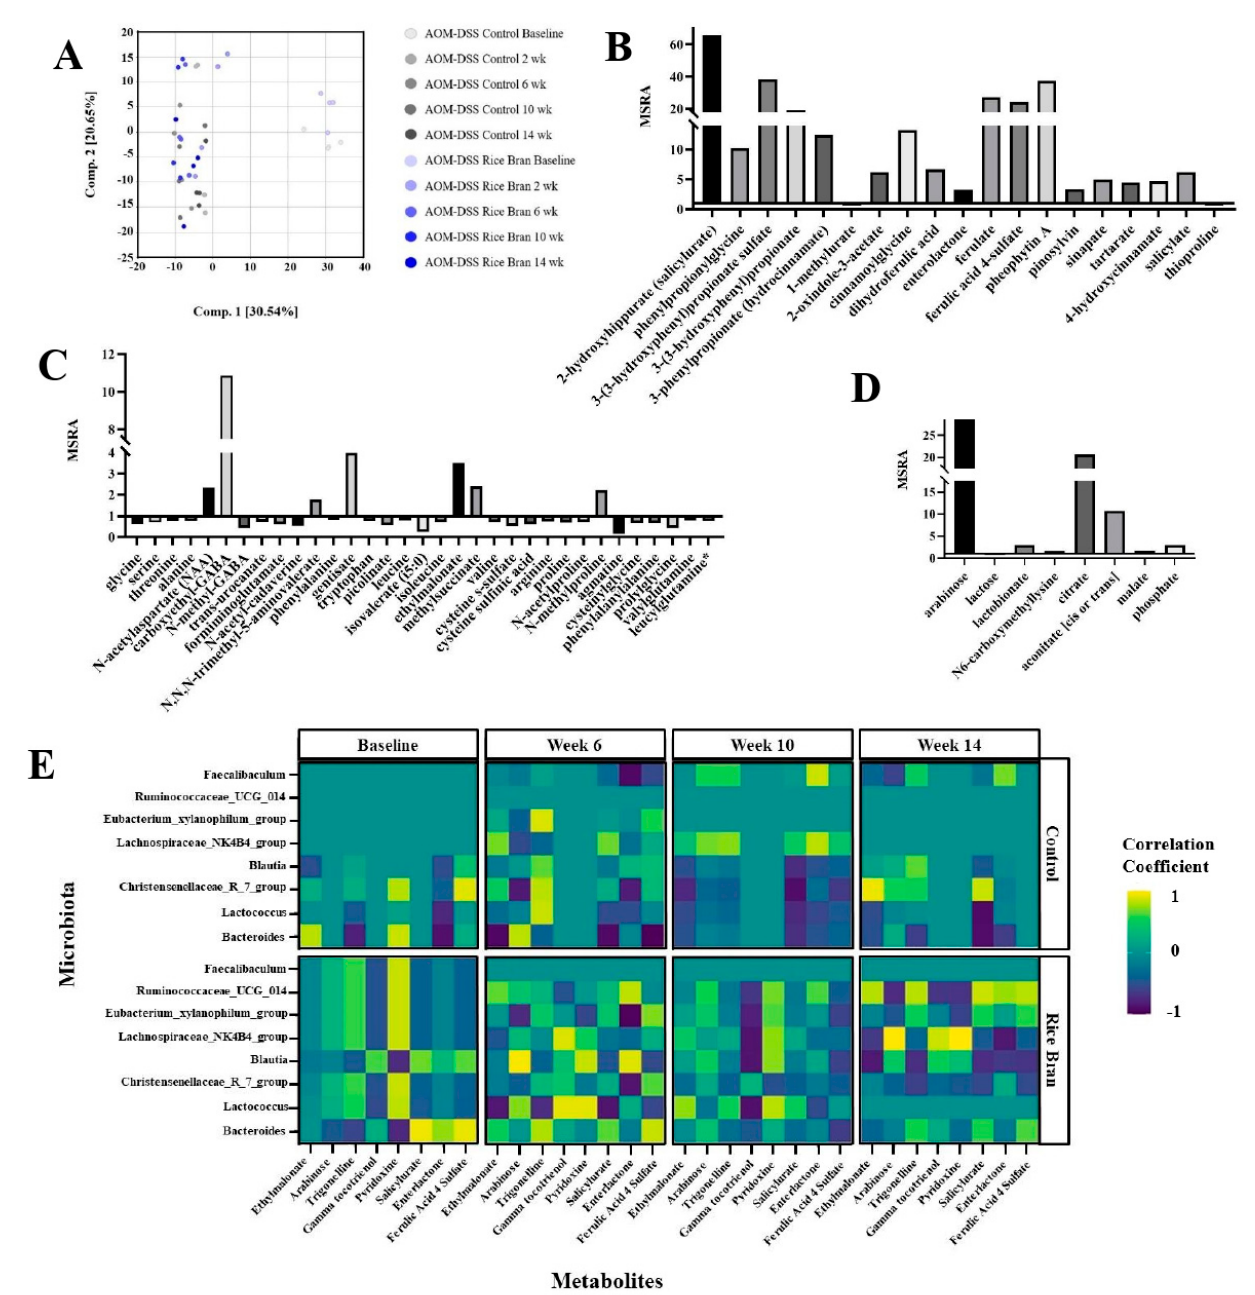
Figure 3. Fecal metabolite profiles modified by rice bran intake in AOM/DSS-treated mice. ( A ) PCA demonstrates segregation of the baseline to the 2- to 14-week time points. Stool metabolite mean rela- tive scaled abundance (MSRA) fold difference with statistical significance between mice fed rice bran and the control at 14 weeks ( p < 0.05) and clustered into chemical classifications as ( B ) phytochemicals, ( C ) amino acids and peptides, and ( D ) carbohydrates and energy. ( E ) Pearson correlation heatmap depicting selected gut microbiota and fecal metabolites in AOM/DSS mice at baseline, week 6, week 10, and week 14, for both the control and rice bran groups. Cofactors and vitamins were increased in fecal abundance for the rice bran group at weeks 10 and 14. Notably, rice bran intake increased nicotinate (e.g., quinolinate, trigonel- line), pantothenate, CoA (e.g., pantetheine), tocopherol (e.g., alpha-tocotrienol, gamma- tocotrienol), vitamin A (e.g., carotene diol), thiamin (e.g., thiamin), and vitamin B6 (e.g.,